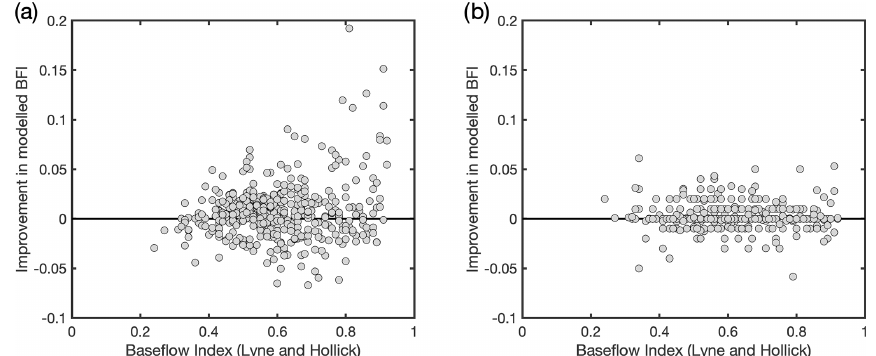
Figure 7. Scatter plots of improvement in modelled BFI as a function of observed BFI_LH for (a) LR and (b) RF models.